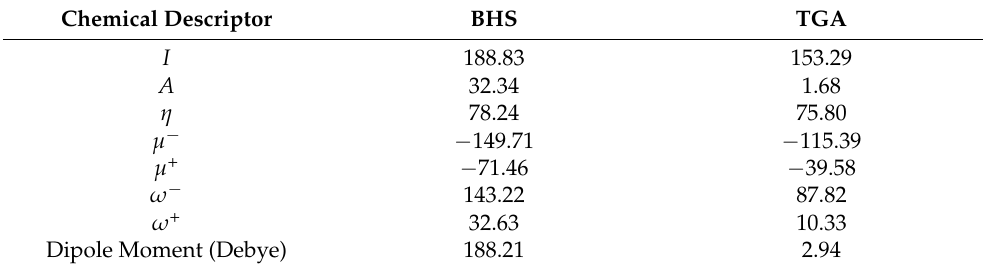
Figure 4. ( A ) Optimized geometry and ( B ) HOMO orbital of [B 12 H 11 SH] 2 − . Table 2. Theoretical chemical descriptors acquired: ionization energy ( I ), electron affinity ( A ), chemical hardness ( η ), chemical potential governing charge donating ( µ − ) and accepting ( µ + ) processes, electrodonating ( ω − ), and electroaccepting ( ω + ) powers. All data are in